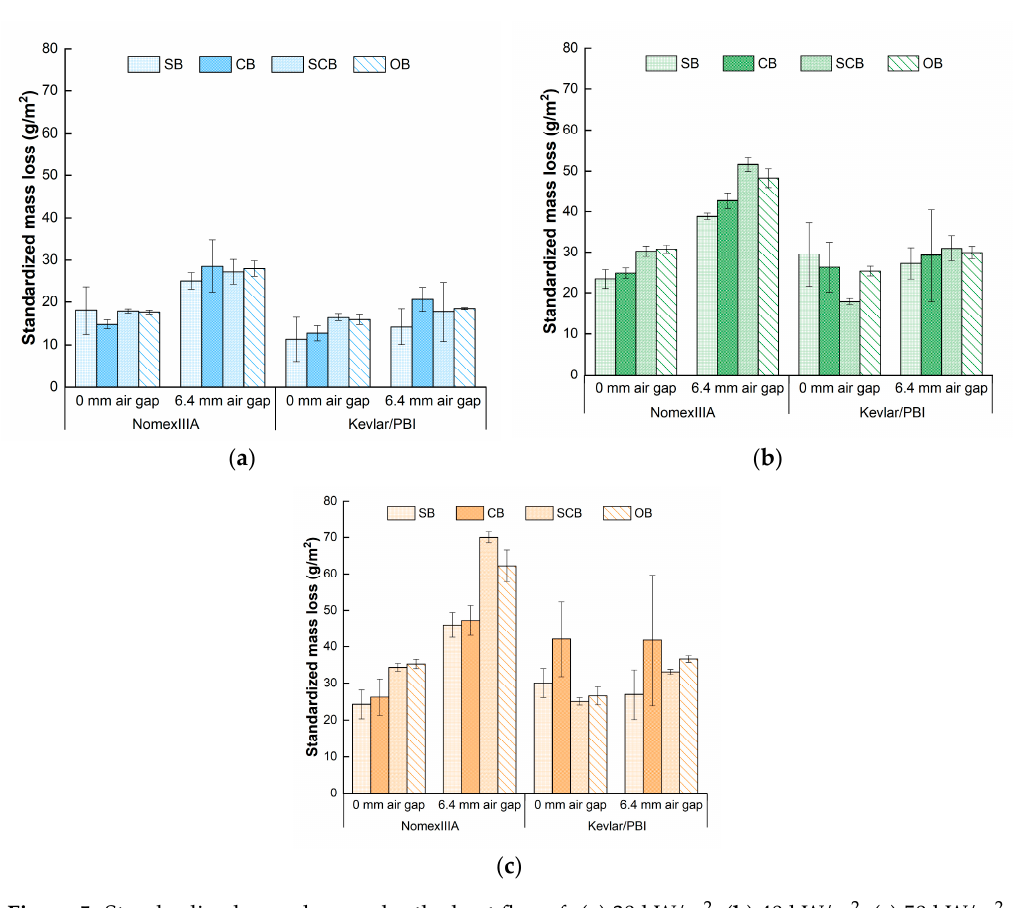
Figure 4. Surface area retention under the heat flux of: ( a ) 30 kW/m 2 ; ( b ) 40 kW/m 2 ; ( c ) 50 kW/m 2 .SB— standard boundary; CB—confined boundary; SCB—semiconfined boundary; OB—open boundary.